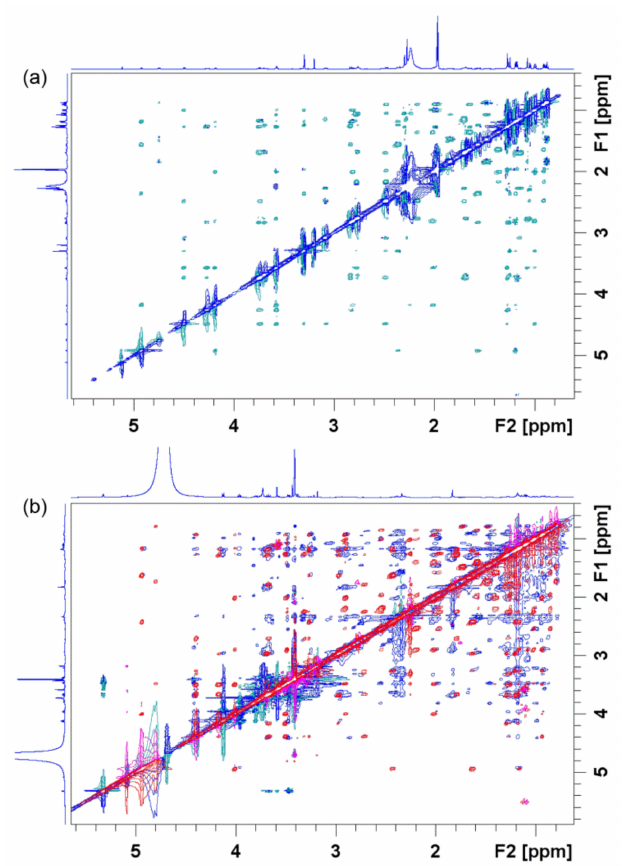
Figure 6. Nuclear Overhauser e ff ect spectroscopy (NOESY) spectrum of 4”-aminopropyl azithromycin in ( a ) acetonitrile-d 3 prior to addition of the E. coli ribosome compared with ( b ) NOESY (red and pink signals) and transferred nuclear Overhauser e ff ect spectroscopy (trNOESY) spectrum (blue and green signals) of the same compound in Tris-d 11 bu ff er (pH 7.4) prior to and after addition of the E. coli ribosome, respectively. The spectra were recorded at 25 ◦ C and 600